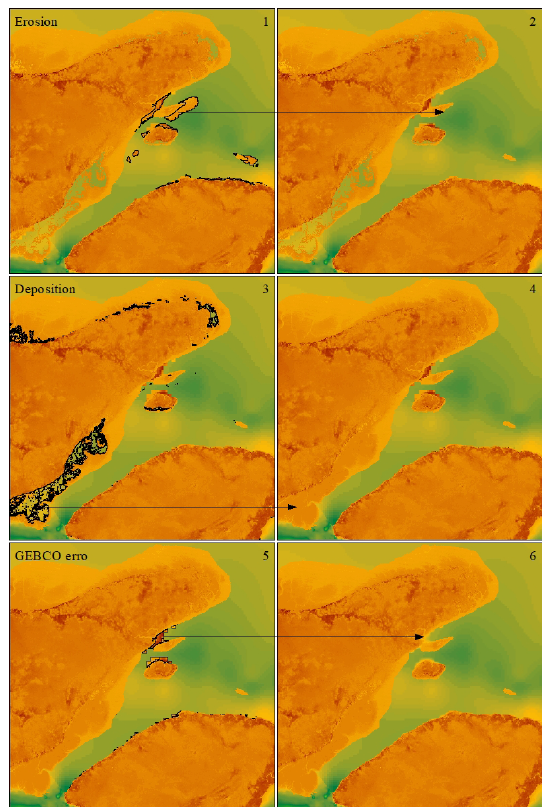
Figure A1. An example of data correction in the ocean after merging the database (GEBCO, MERIT DEM, bathymetry, and topography).